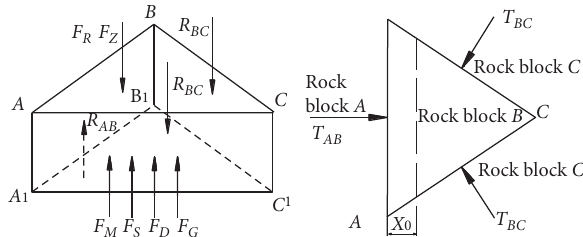
Figure 2: Structural stress of surrounding rocks of the key rock block